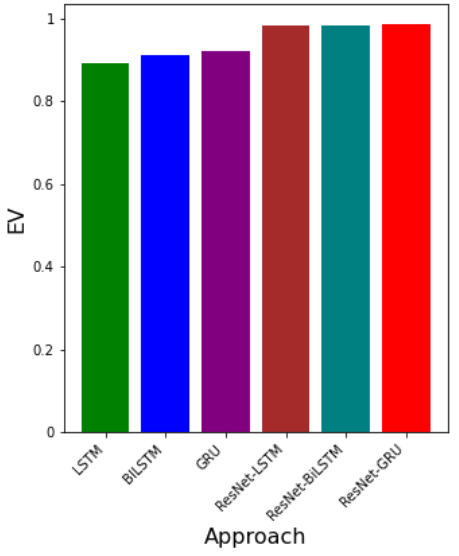
Figure 16. The graph of EV values for each approach.